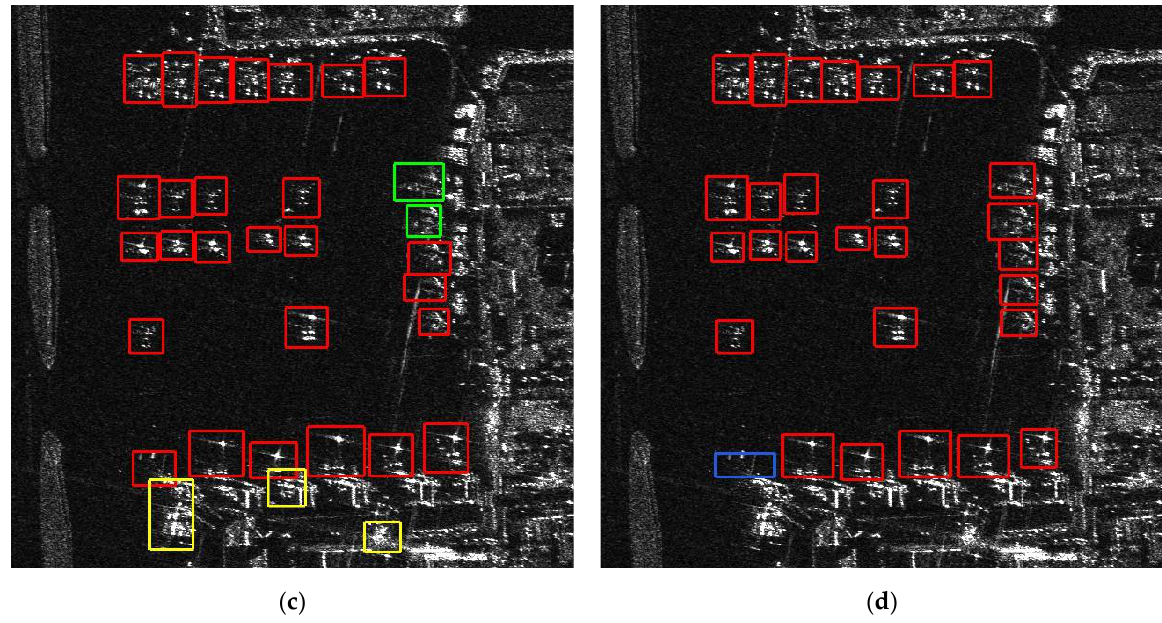
Figure 6. The results for scene I of Shanghai Hongqiao Airport. ( a ) The ground truth from Gaofen-3. ( b – d ) The detection results by YOLOv5, YOLOX, and SOAEN, respectively. The correct detection, the missed detection, false alarms, and inaccurate bounding boxes are indicated by red, green, yellow, and blue boxes, respectively.